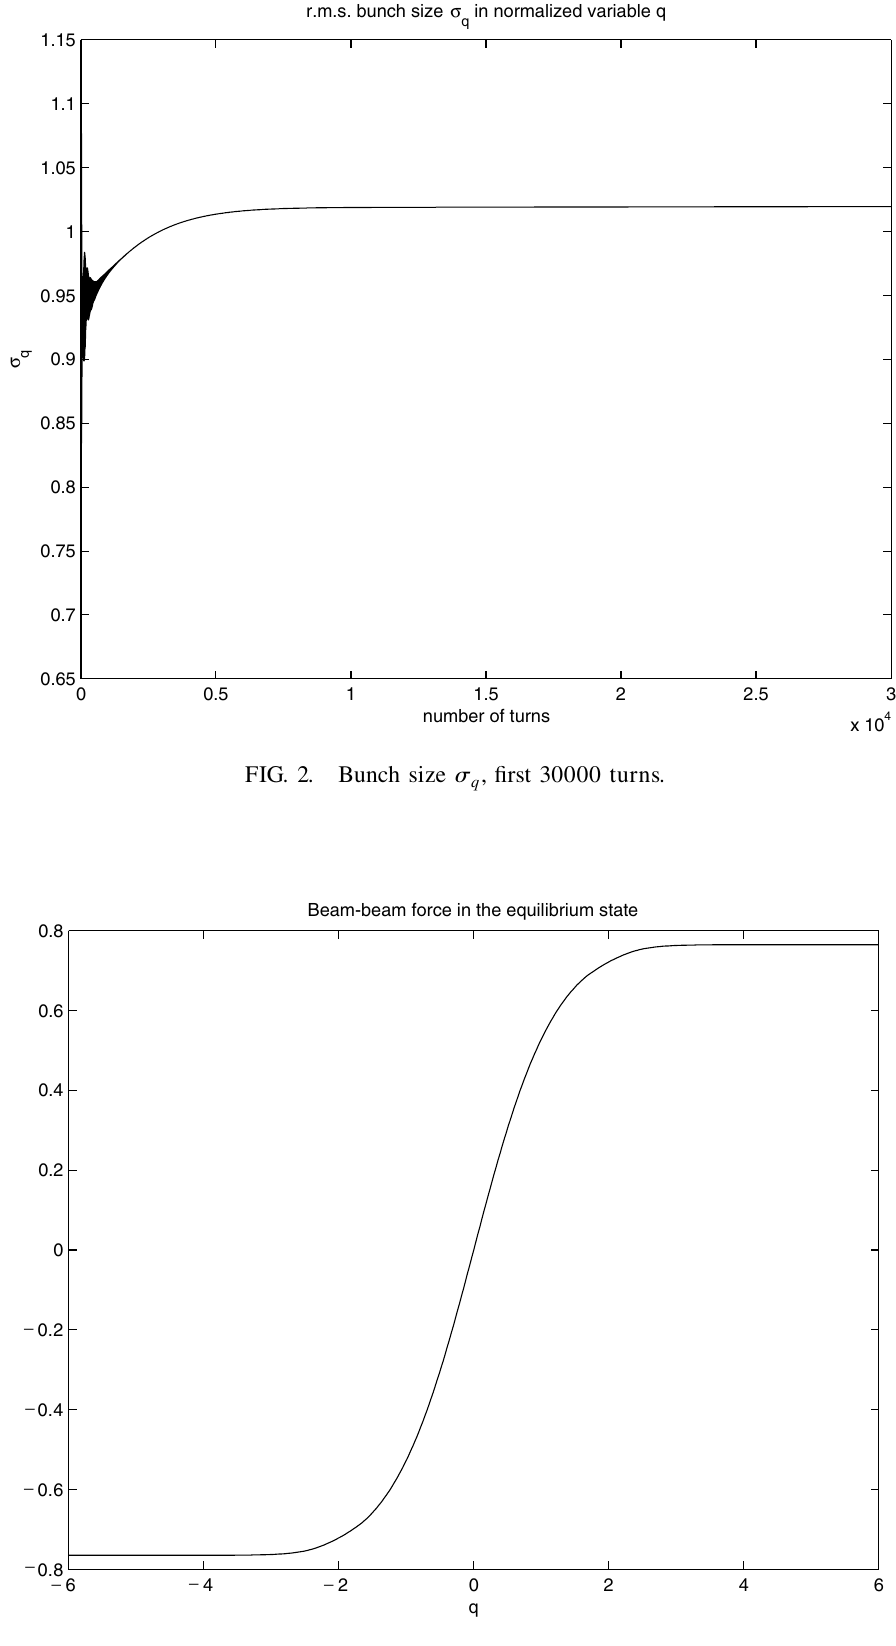
FIG. 3. Beam-beam force in equilibrium